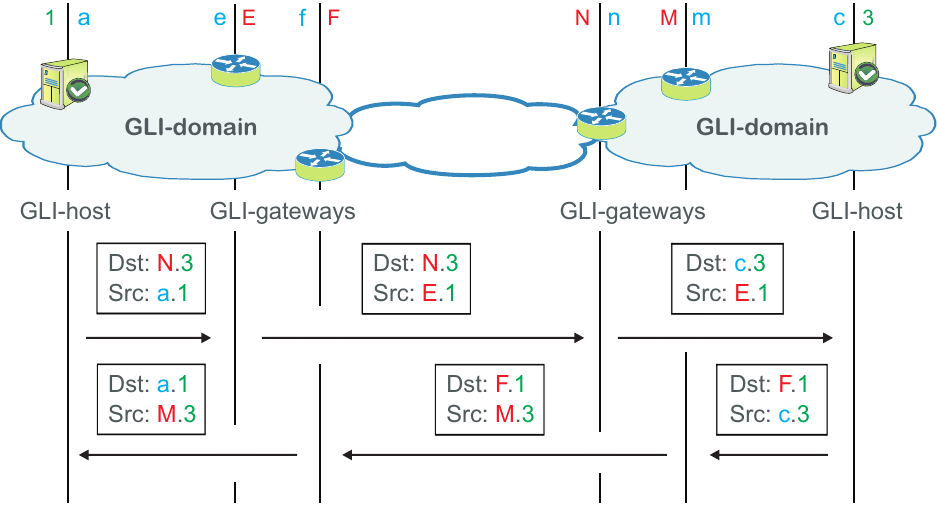
Communication process with horizontal address translation between two GLI-domains. GLI-node 1 sends a packet to node 3 in a different GLI-domain and node 3